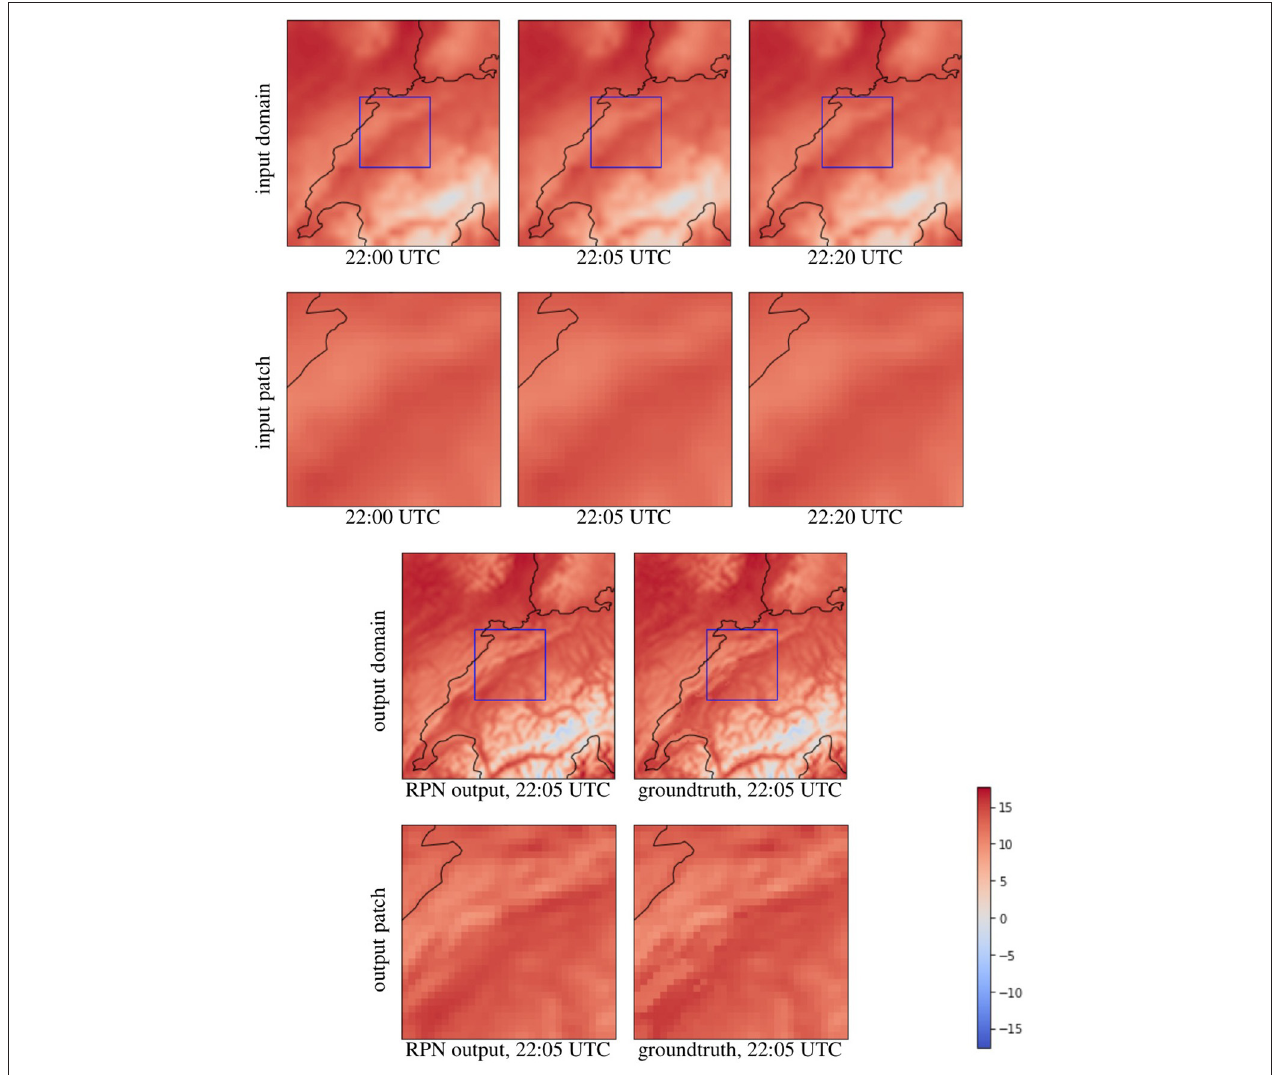
FIGURE 4 | Downscaling results for temperature (in ◦ C) by a factor of k x = k y = k t = 4 in both the temporal and spatial dimension. The first row shows time steps of the trivially downscaled domain. The second row shows a patch as it is sent into the network. The third row compares the result of the network to the groundtruth on the full domain. The last row shows the groundtruth comparison for the patch that was